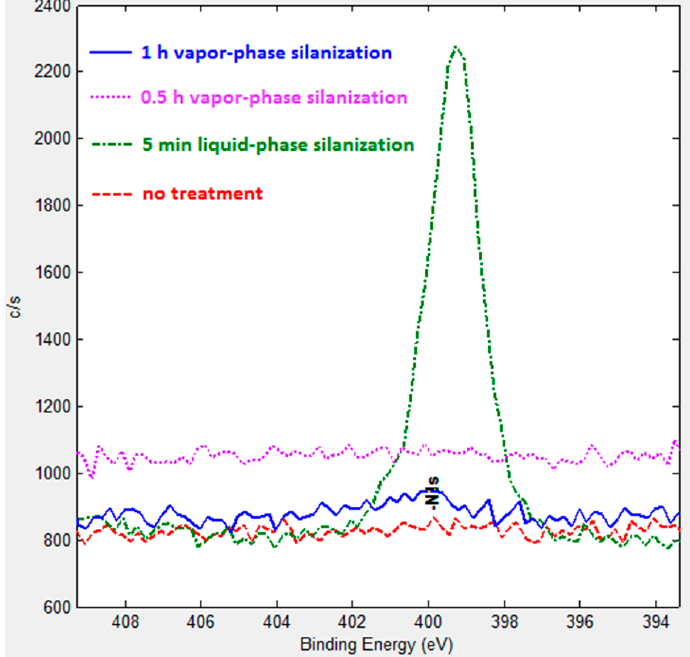
Figure 3. The N 1s spectra of the PDMS surfaces by XPS under different surface modifications.